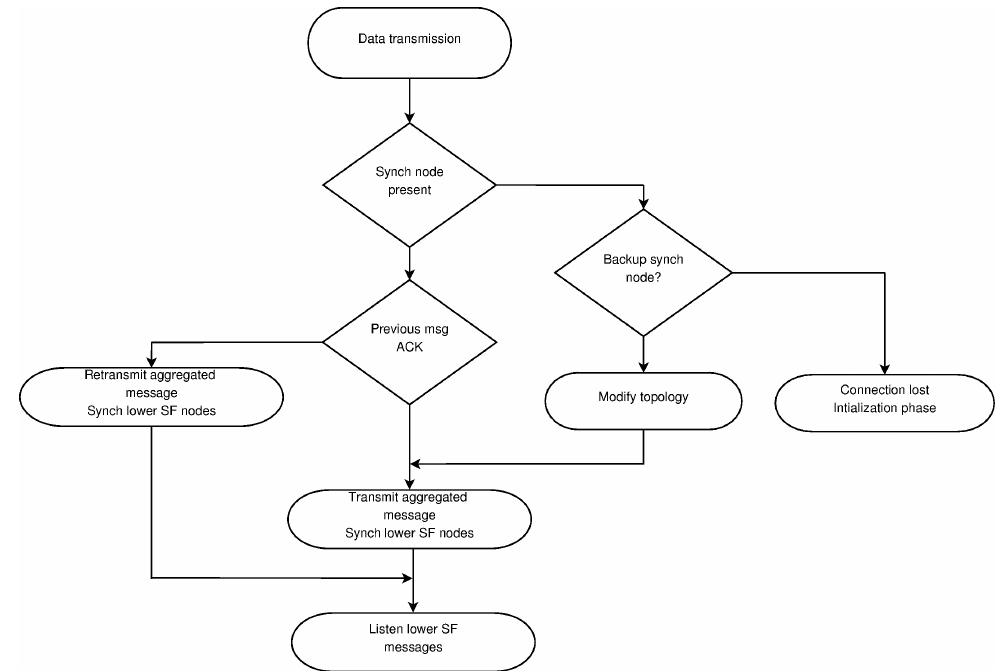
Figure 9. Data transmission